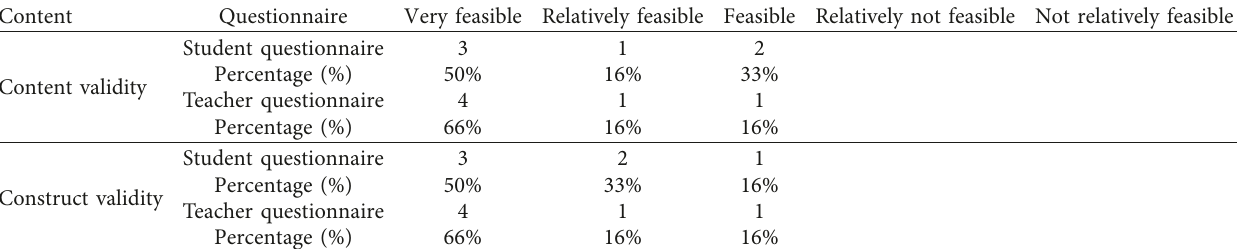
Table 2: Validity test expert evaluation results ( n � 6).